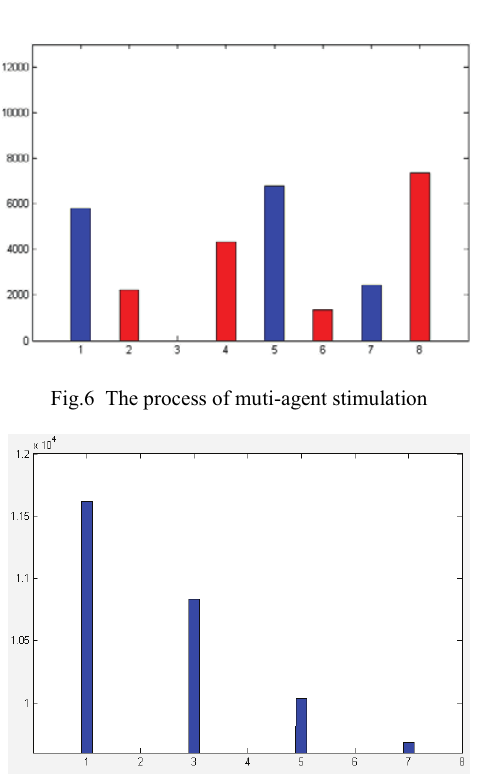
Fig.7 The profits of four kinds of